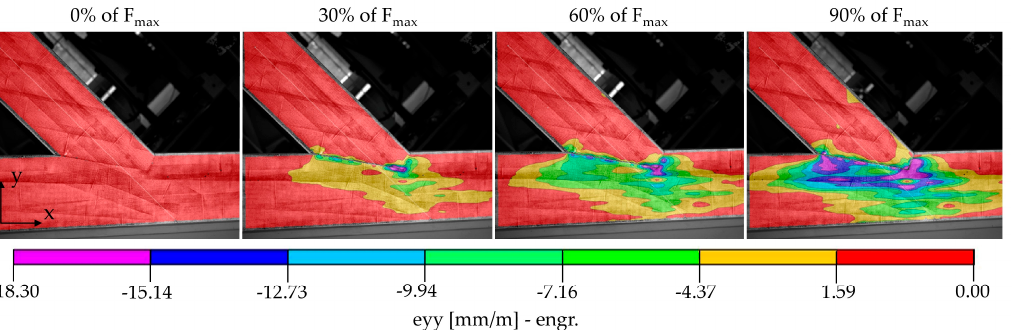
Figure 3. Normal strains eyy of the surface of specimen A_5 measured using the DIC system at 0%, 30%, 60% and 90% of the ultimate load F max at 124.08 kN.